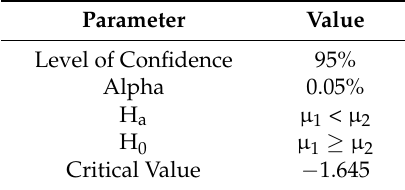
Table 14. Parameters for the statistical z-test.